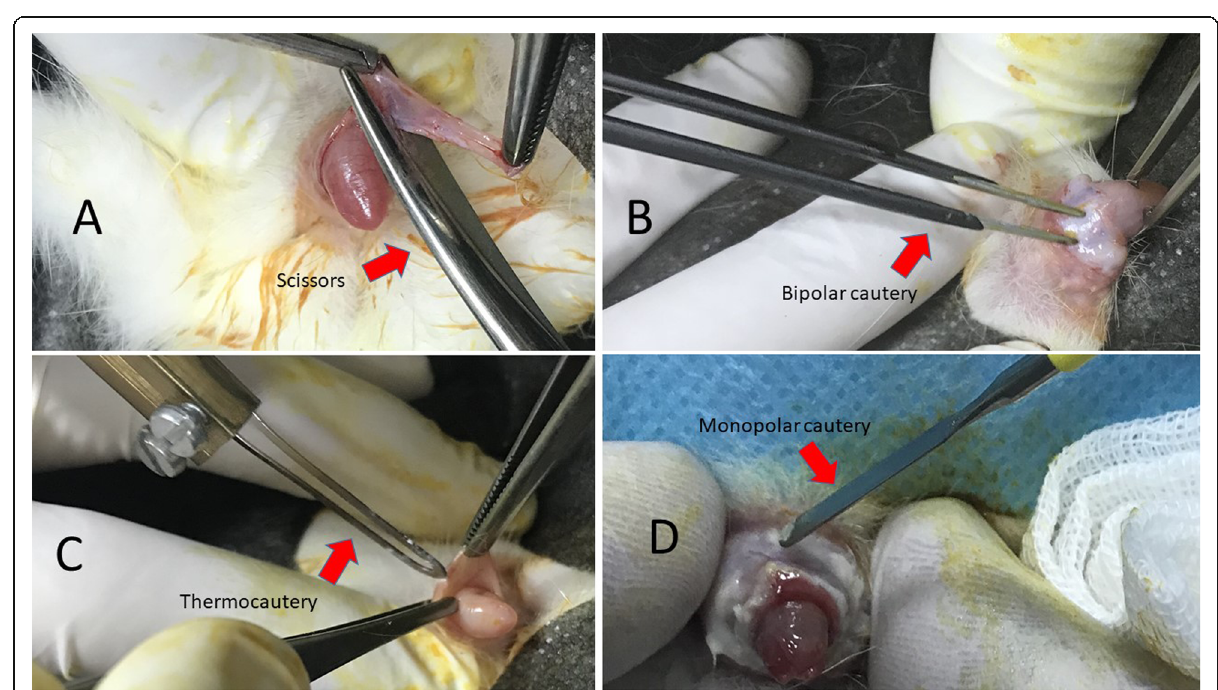
Fig. 1 Views of circumcision technique and cautery devices. a surgical circumcision, b bipolar cautery, c thermocautery, d monopolar